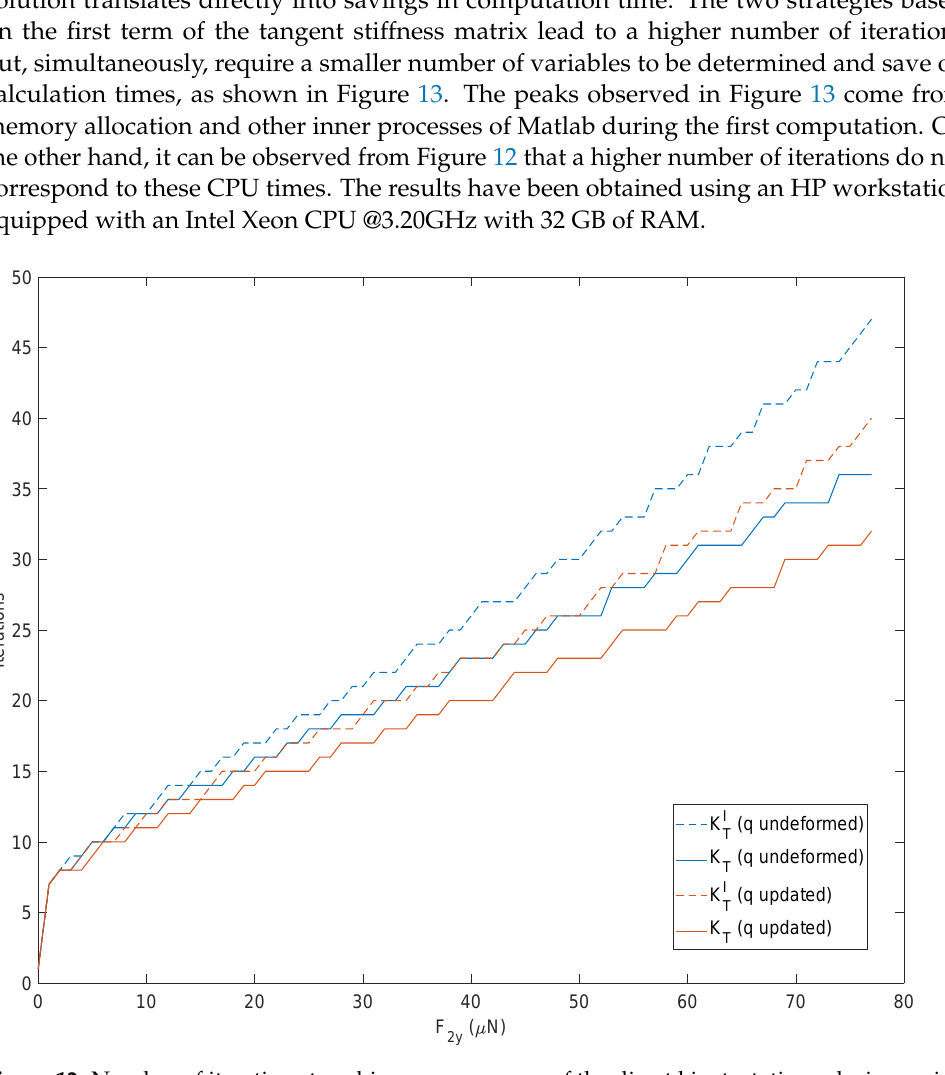
starting each simulation from the T starting each T